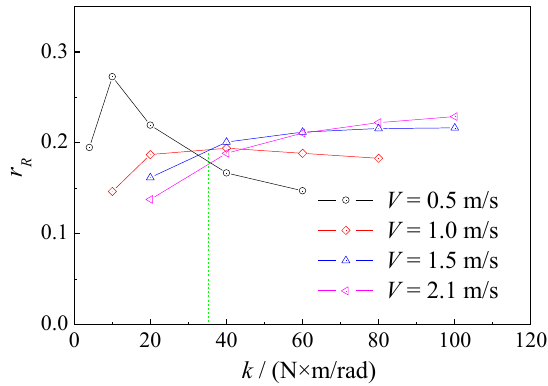
Figure 16. Resistance reduction ratio 𝑟 𝑅 of bow foil with different speeds and different spring stiffness.